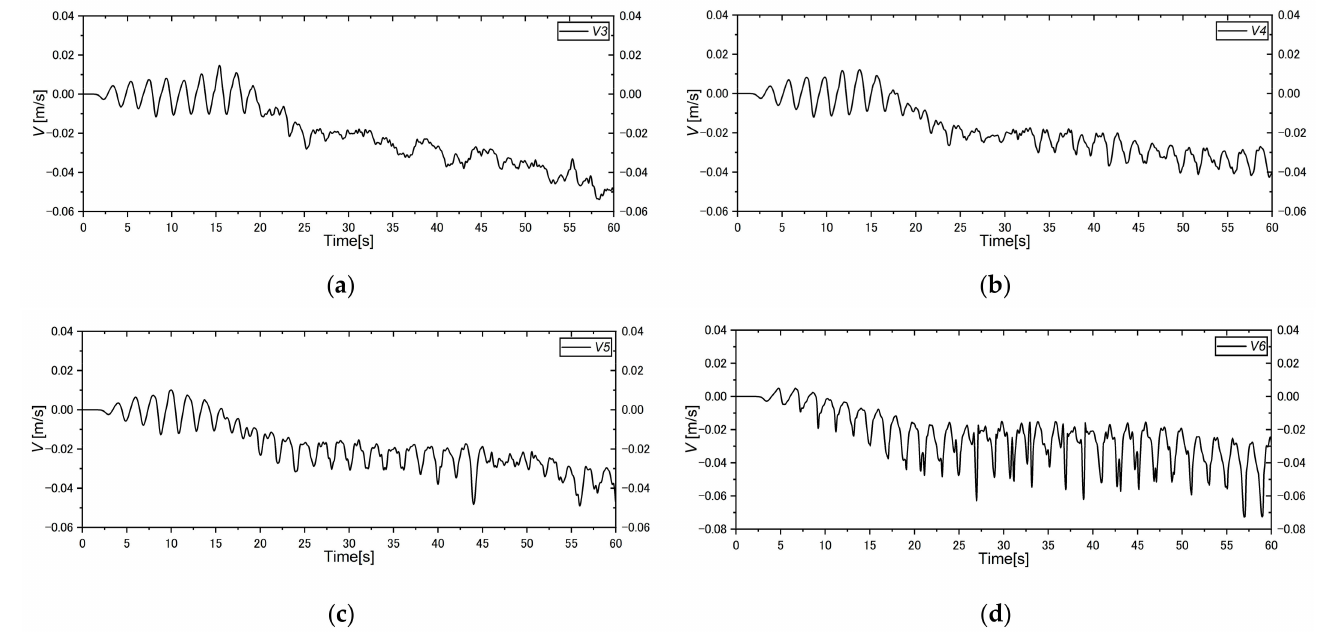
Figure 15. Longshore-shore velocity profiles in cross-section 1 at ( a ) V3 ( r = 300 cm), ( b ) V4 ( r = 336 cm), ( c ) V5 ( r = 369 cm), and ( d ) V6 ( r = 405 cm) in case 2 (T-2.0